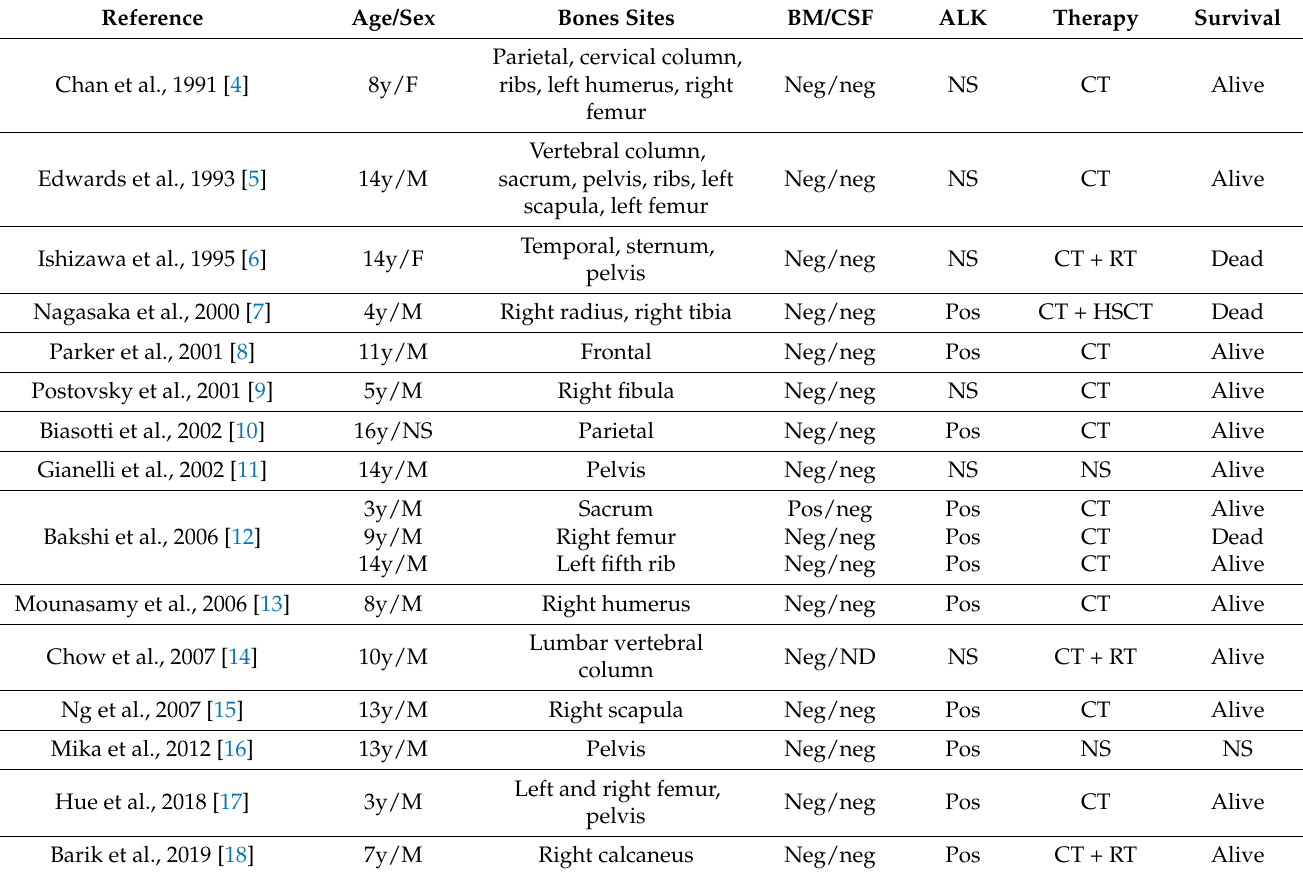
Table 2. Characteristics of reported pediatric patients with primary bone